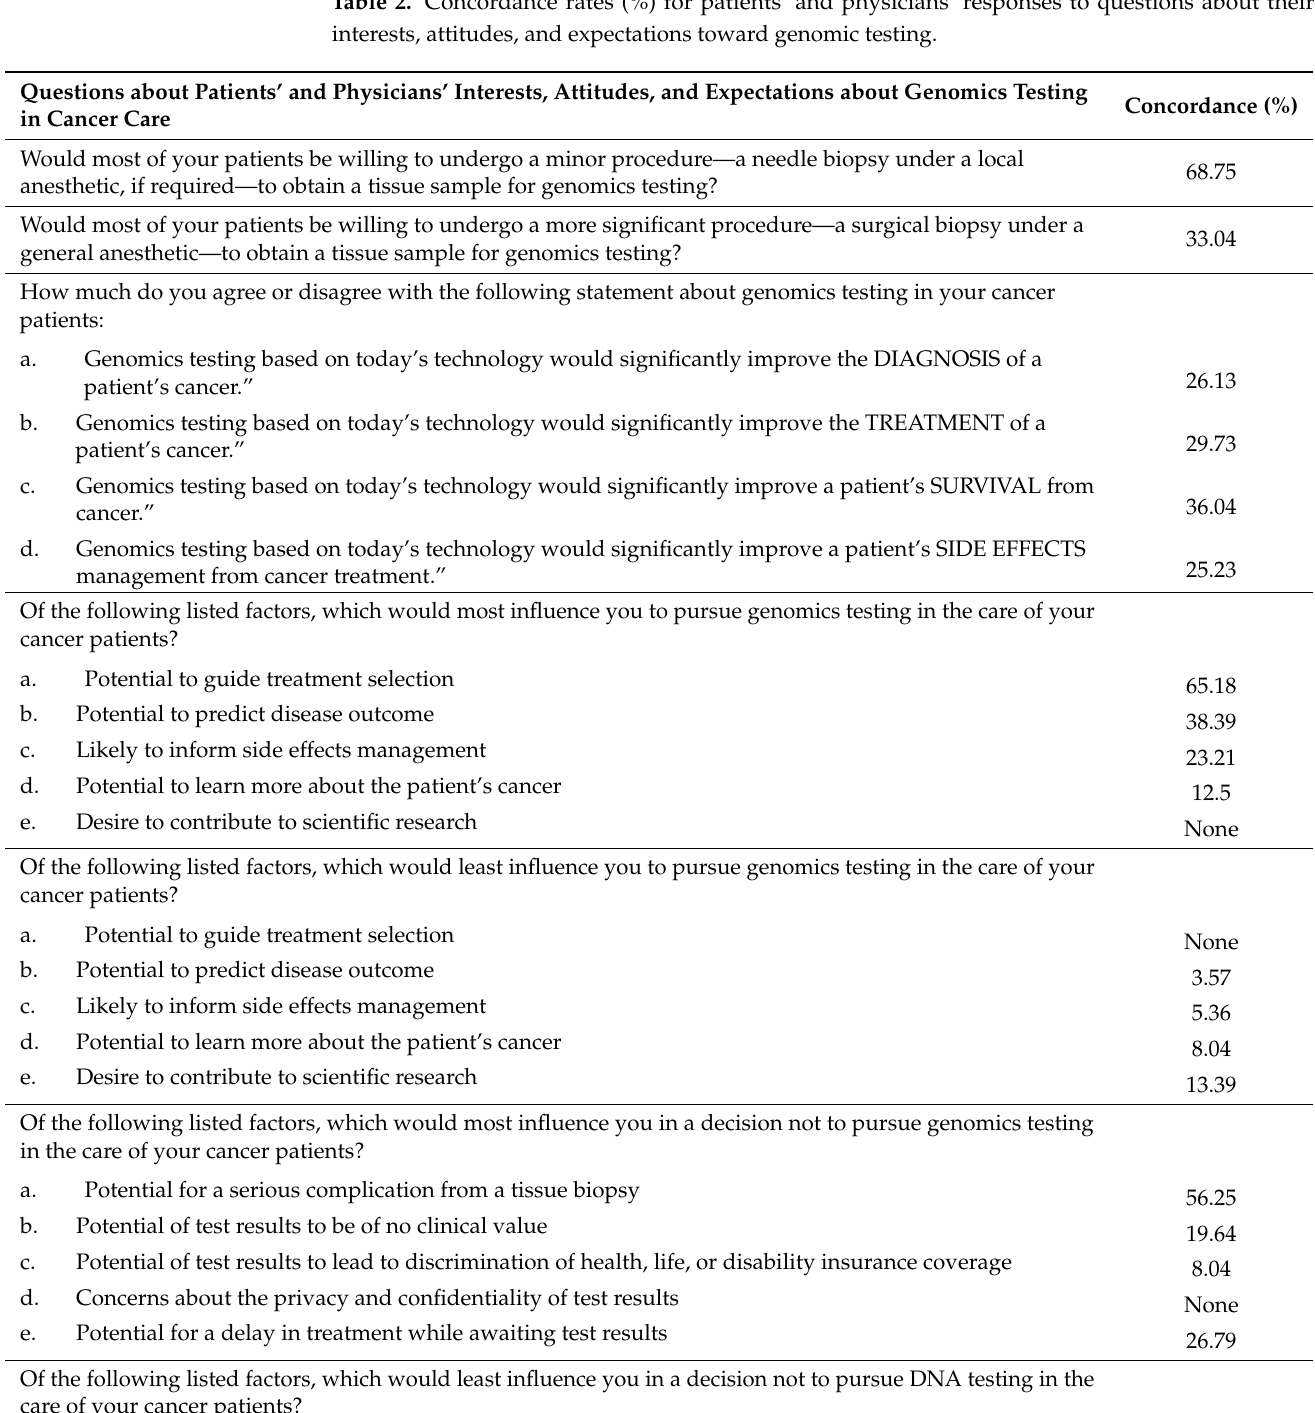
Table 2. Concordance rates (%) for patients’ and physicians’ responses to questions about their interests, attitudes, and expectations toward genomic